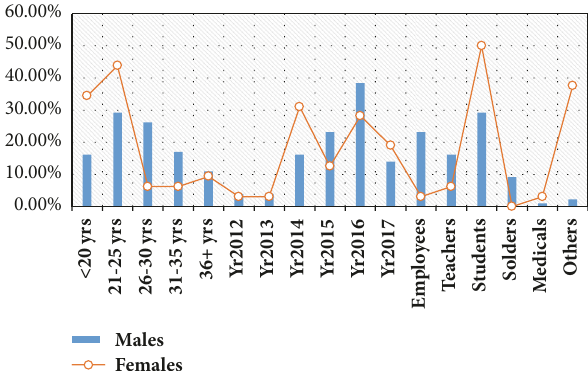
Figure 2: Description of the study population by gender and demographical